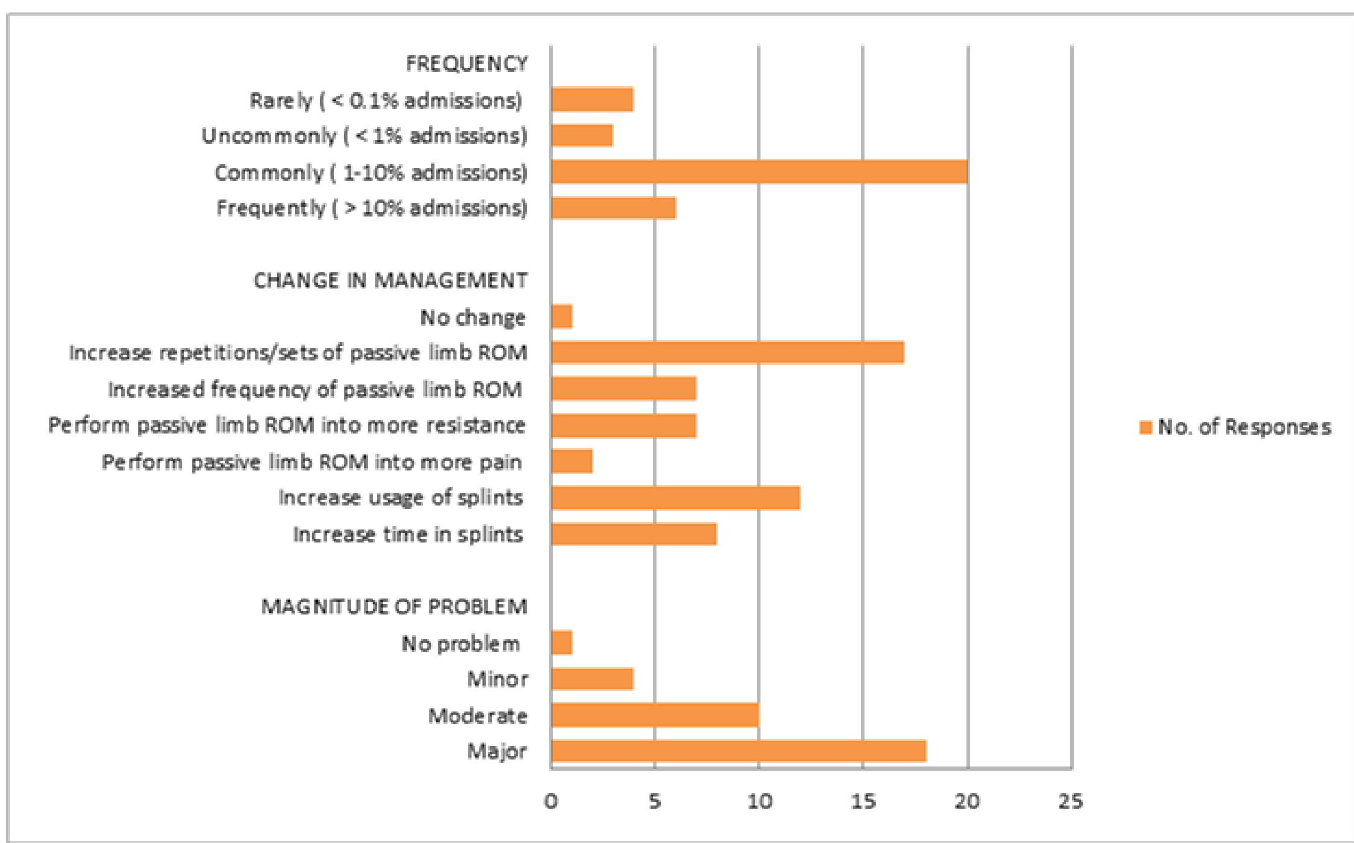
Fig 3. Frequencies for the incidence, magnitude of the problem, and management in relation to loss of passive limb range of motion/contracture reported by the 33 respondents.